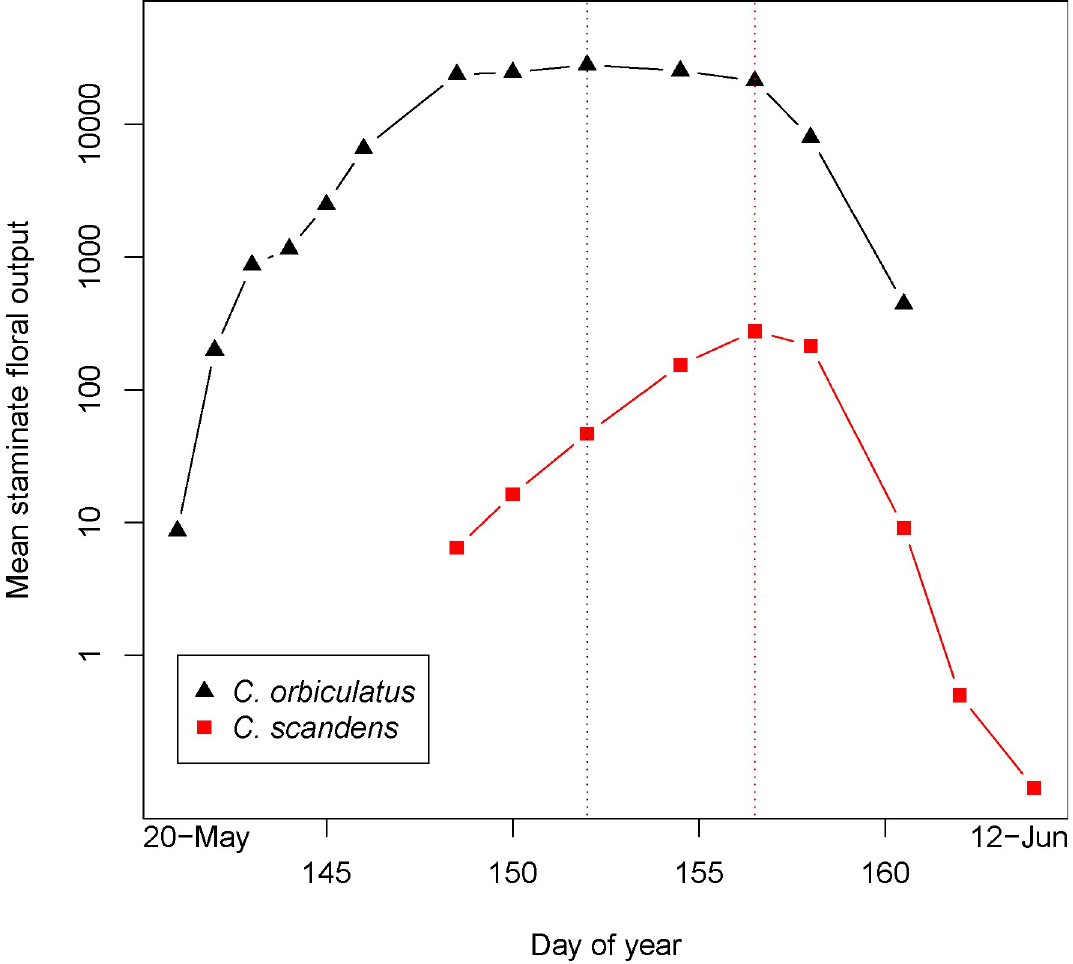
Fig 2. Mean staminate floral production per day. Observations made across 19 staminate individuals in C . scandens (red squares) and 25 staminate individuals in C . orbiculatus (black triangles). Vertical dotted lines represent the dates of peak flowering in C . orbiculatus (31 May, black line) and C . scandens (5 June, red